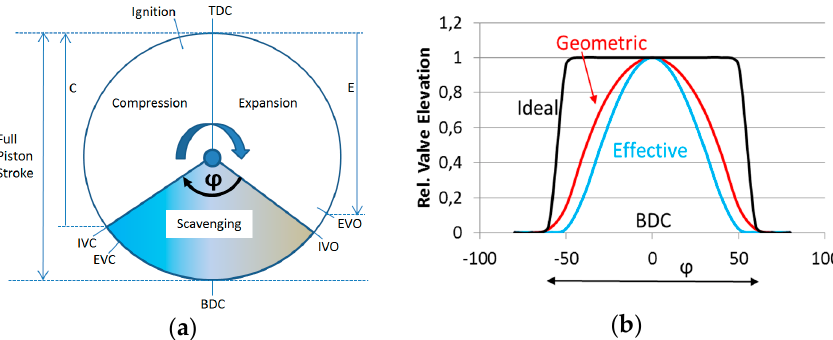
Figure 1. ( a ) 360° crankshaft cycle for a 2-stroke engine with conventional poppet valves. The full rotation can be separated into three sectors: Compression (including ignition), expansion, and scavenging. As a challenge, the scavenging angle ϕ is rather limited to leave a sufficient compression stroke C and expansion stroke E with respect to the fully available piston stroke. ( b ) Normalized valve elevation within ϕ . The effective cross-section (blue) for scavenging is smaller than the geometrical valve stroke (red) and accounts for only 50% of an ideal ( = unrealistic) valve with instantaneous open / close characteristics (black). The abbreviations are as follows: TDC = piston’s top dead center, E = expansion stroke, EVO = exhaust valve opening, IVO = intake valve opening, BDC = bottom dead center, EVC = exhaust valve closing, IVC = intake valve closing, and C = compression stroke. The scavenging angle ϕ is determined by the camshaft profile and strongly determines the whole approach.